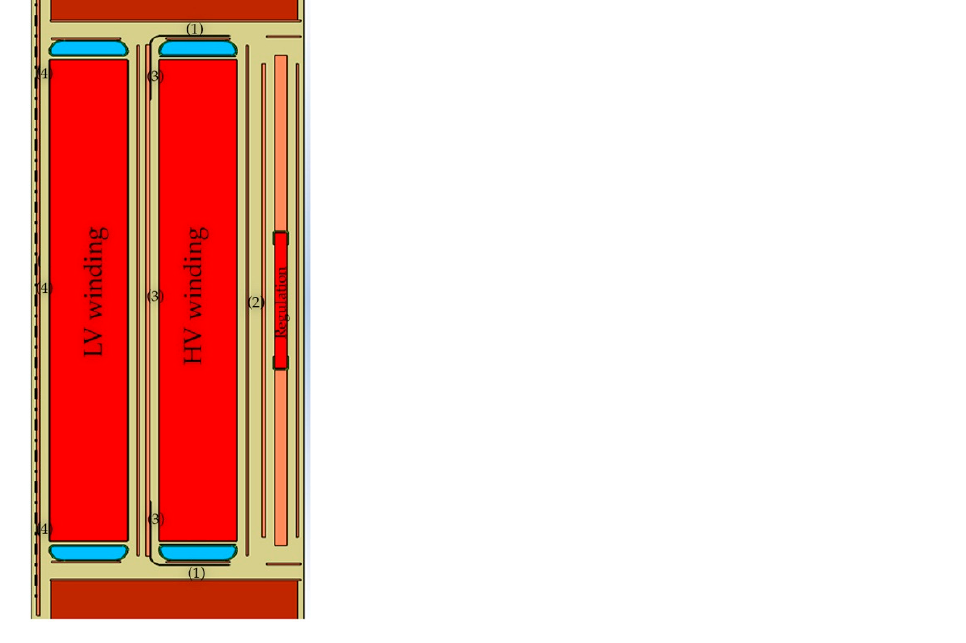
Figure 9. Electric field analysis points: (1) HV top and bottom winding; (2) HV to regulation windings; (3) HV to LV windings; (4) LV to core. (3) HV to LV windings; (4) LV to